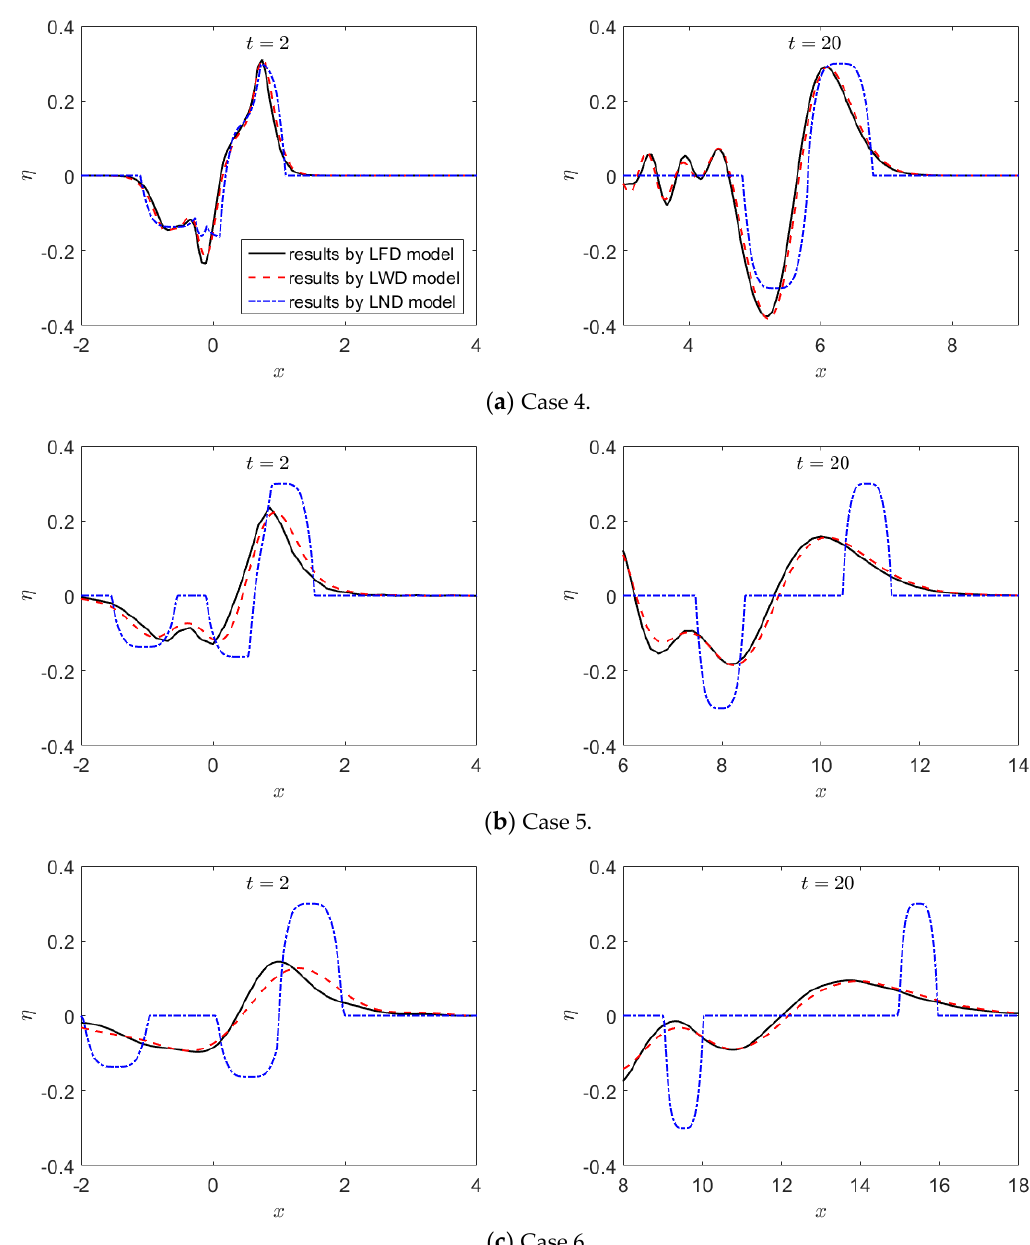
Figure 5. Comparisons of semielliptical landslide-generated water waves obtained by three models.